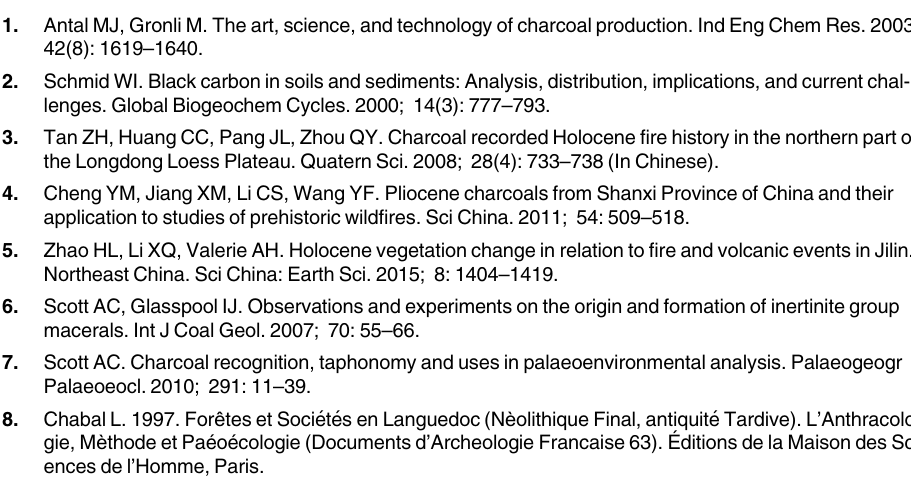
S2 Table. The representative coefficient R-value of different